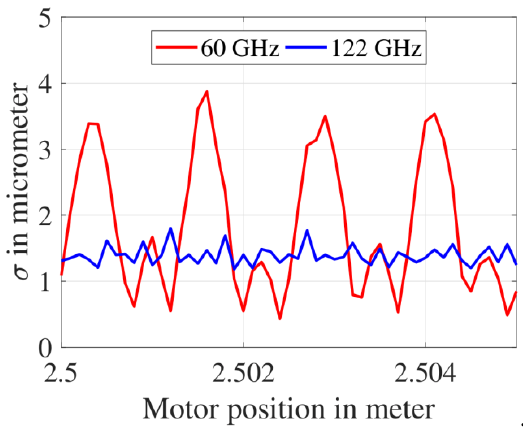
Figure 10. Mean distance measurement error after the combined frequency- and phase-estimation.